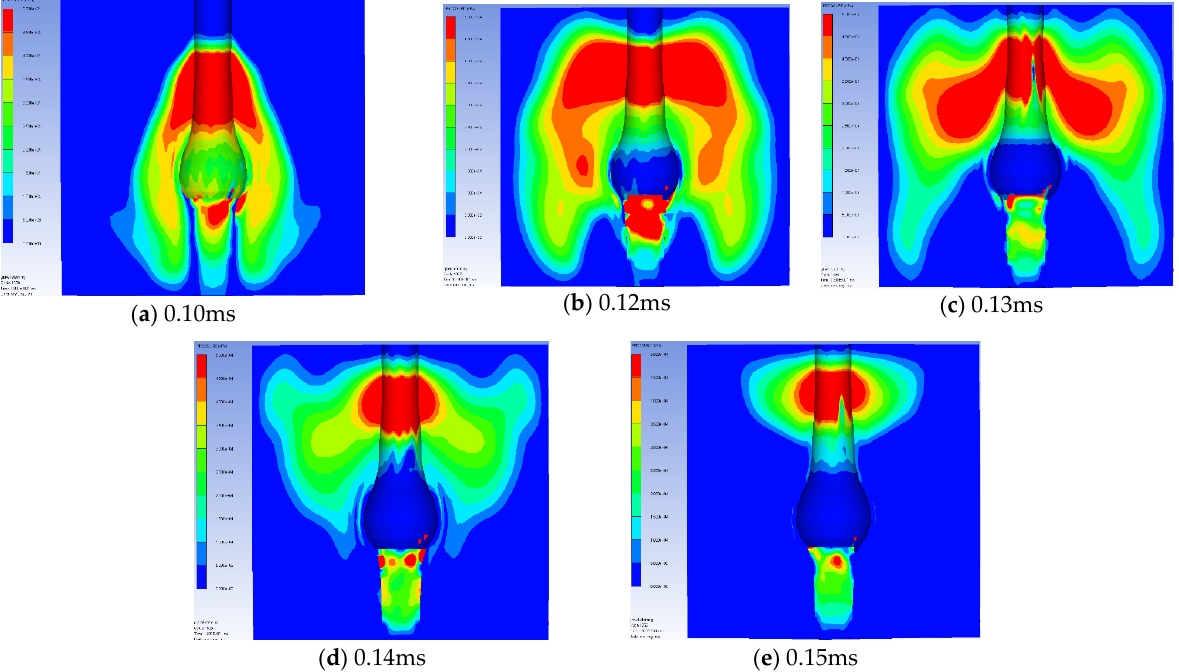
Figure 16. Pressure contour for the lead block model at the initial step (time: 0.1–0.15 ms; sand stemming cases).